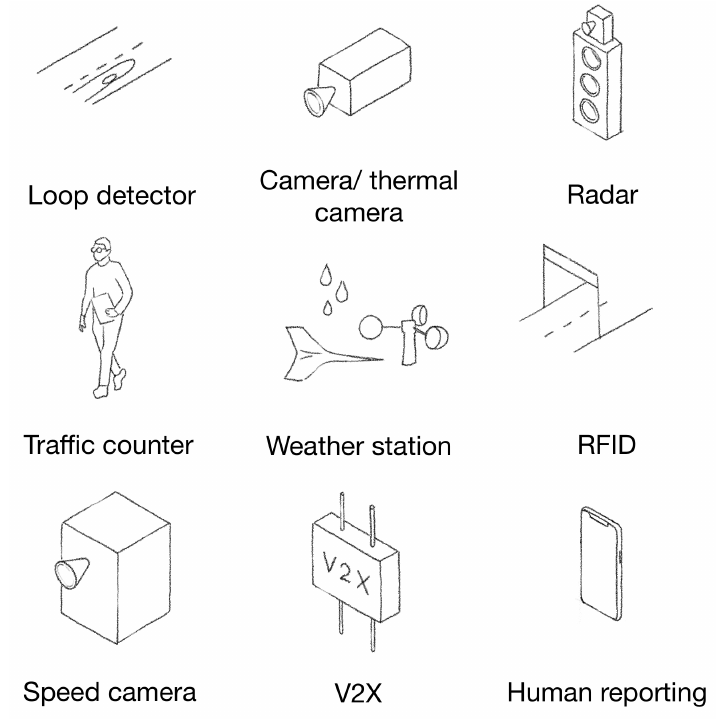
Figure 5. Sensors used by the